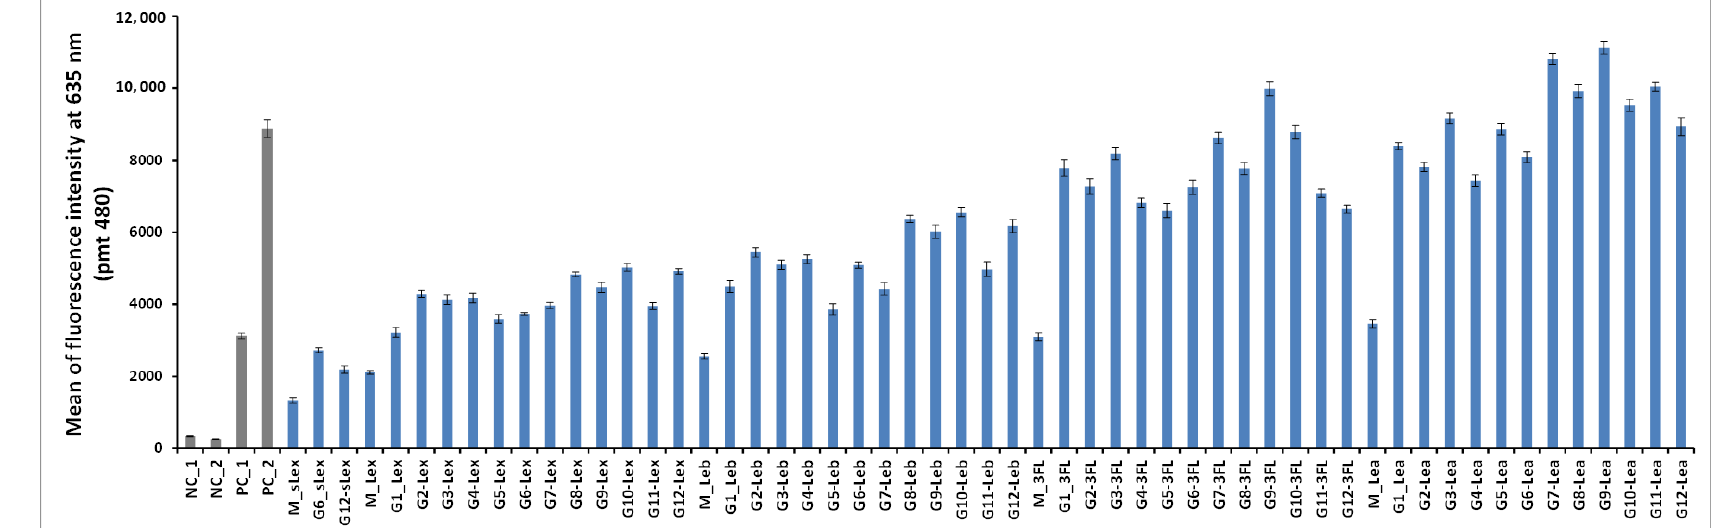
Figure 6. The fluorescent signal of Alexa 647 LecB conjugate was recorded as a function of the oligoglycoclusters. NC and PC stand for negative and positive control. Structures of NC_2, PC_1 and PC_2 are displayed Figure 7. NC_1 is a single stranded DNA. G1 and G2 are arabinose-centered clusters with an EG 2 or EG 4 linker respectively. In a similar manner, G3 and G4 are xylose-centered, G5 and G6 ribose-centered, G7 and G8 glucose-centered, G9 and G10 galactose-centered, and finally G11 and G12 mannose-centered. Average and error bars were calculated from 32 repetition spots from one experiment.